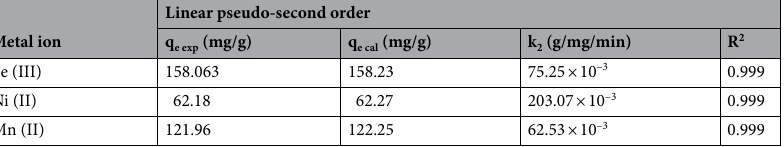
Table 2. Calculated parameters of the linear pseudo-second-order kinetic models for Fe 3+ , Ni 2+ , and Mn 2+ sorbed onto the modified (GO-C).